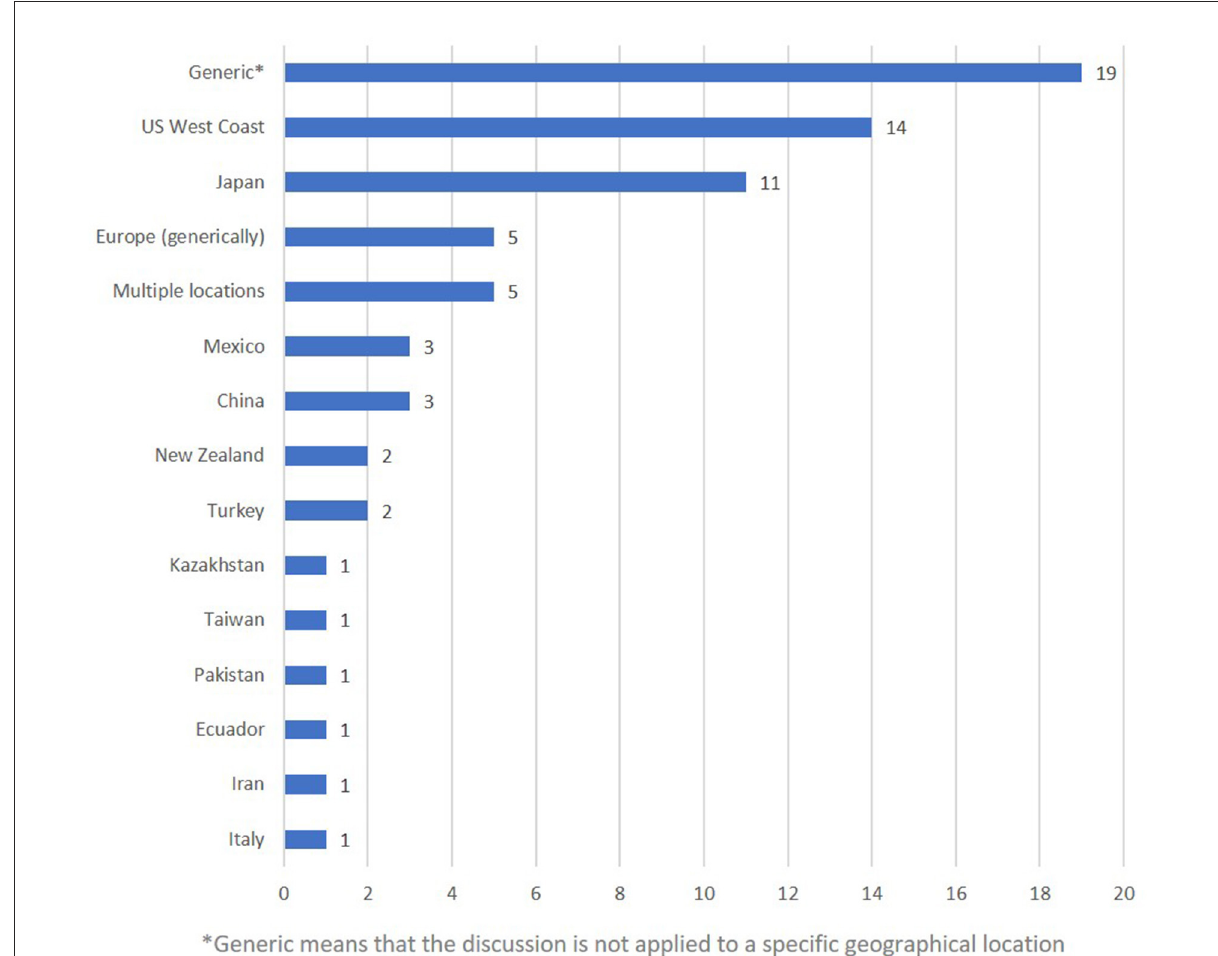
FIGURE2 Locations of focus for the articles included in this literature